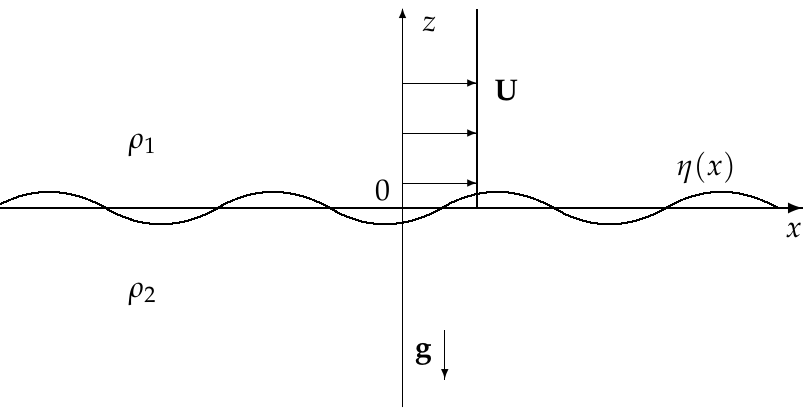
Figure 1. Schematic sketch of the airflow model with the tangential discontinuity above the ice covered deep